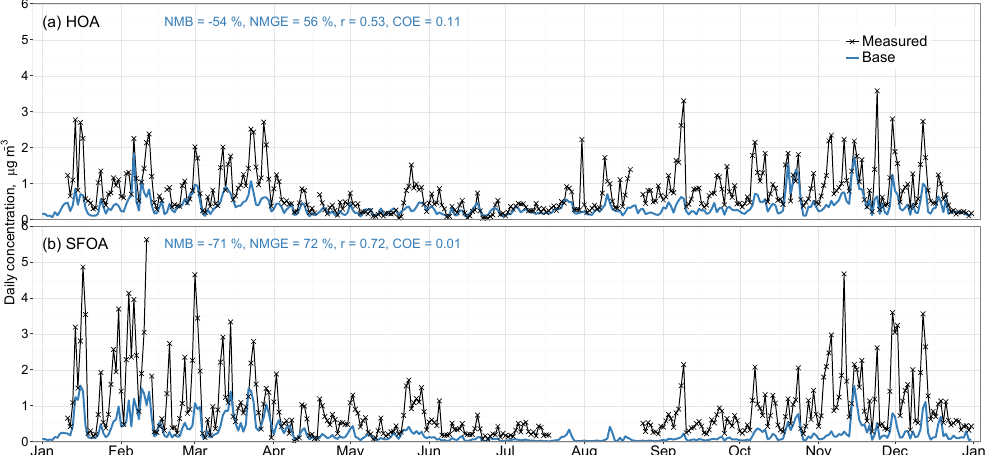
Figure 5. Time series of measured and modelled daily average concentrations of (a) HOA, and (b) SFOA at the London North Kensington urban background site, 2012, measured with the cToF-AMS (Table 3).